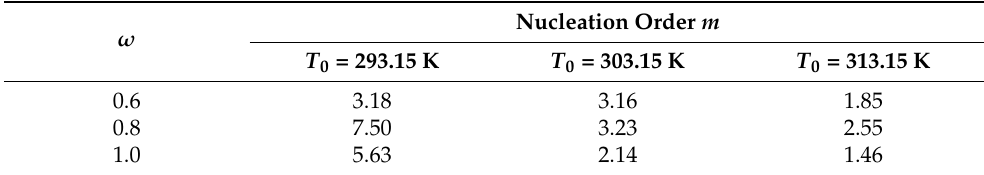
Figure 6. Relationship between MSZW and cooling rate at different saturation temperatures fitted by N ý vlt’s model: ( a ) ethanol mass fraction of 0.6, ( b ) ethanol mass fraction of 0.8, and ( c ) ethanol mass fraction of 1.0. Table 3. Nucleation order m fitted by N ý vlt’s